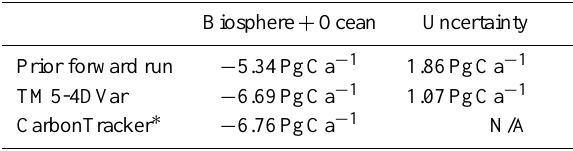
Table 1. Yearly global CO 2 fluxes and uncertainty (standard de- viation) from the prior forward run and from the baseline runs of TM5-4DVar and CarbonTracker. The § column lists important